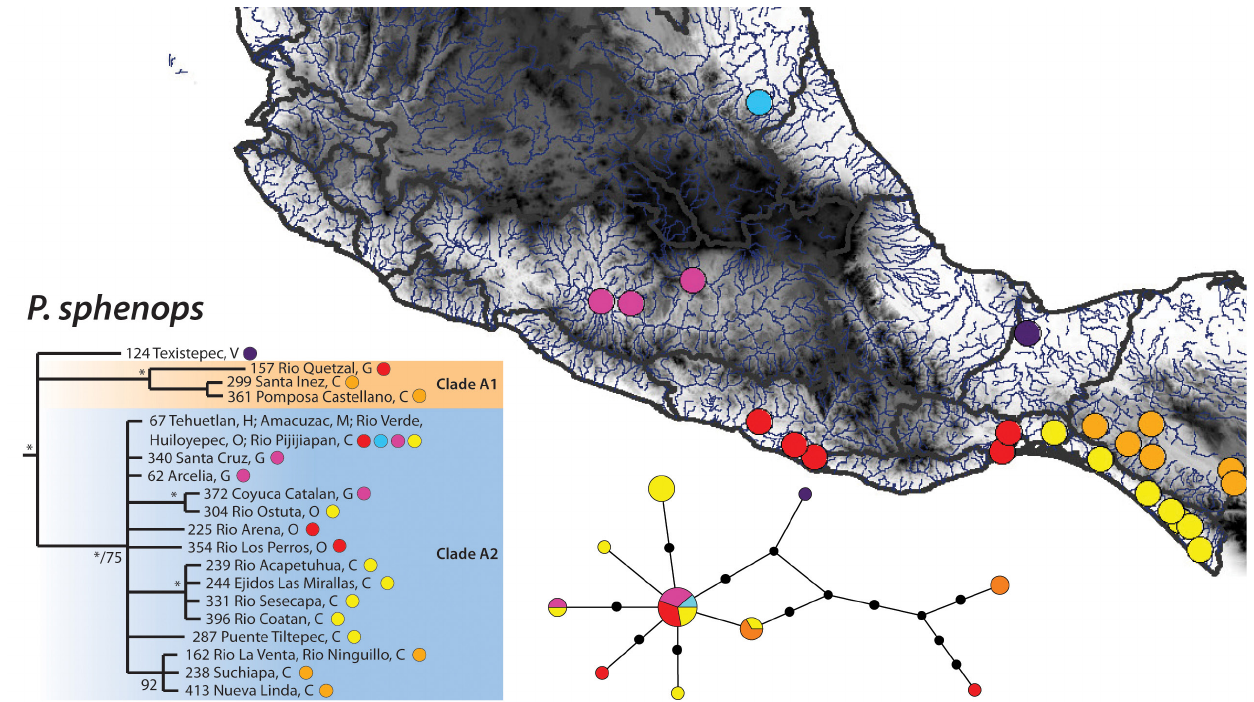
FIGURE 3 | Cytochrome b (1,140 bp) mitochondrial gene Bayesian phylogeny, parsimony haplotype network, and sampling distribution of Poecilia sphenops (aqua-Atlantic North of the Trans Mexican Volcanic Belt, pink- Balsas River Drainage, purple- Atlantic North of the Isthmus of Tehuantepec, red- Pacific North of the Isthmus of Tehuantepec, orange- Atlantic South of the Isthmus of Tehuantepec, and yellow- Pacific South of the Trans Mexican Volcanic Belt) across geographic barriers along the coasts of Mexico. The phylogeny has Bayesian posterior values followed by bootstrap values with asterisks representing support of 95% or above. The Parsimony network values correspond to the haplotype values and are colored according by geographic locations separated by barriers; circle sizes correspond to the number of individuals with that haplotype (larger circles reflect more individuals), and black circles indicate unsampled haplotypes. The capital letters at the end of each sample represents the state of origin in Mexico, from North to South: V = Veracruz, H = Hidalgo, M = Michoacan, G = Guerrero, O = Oaxaca, C =